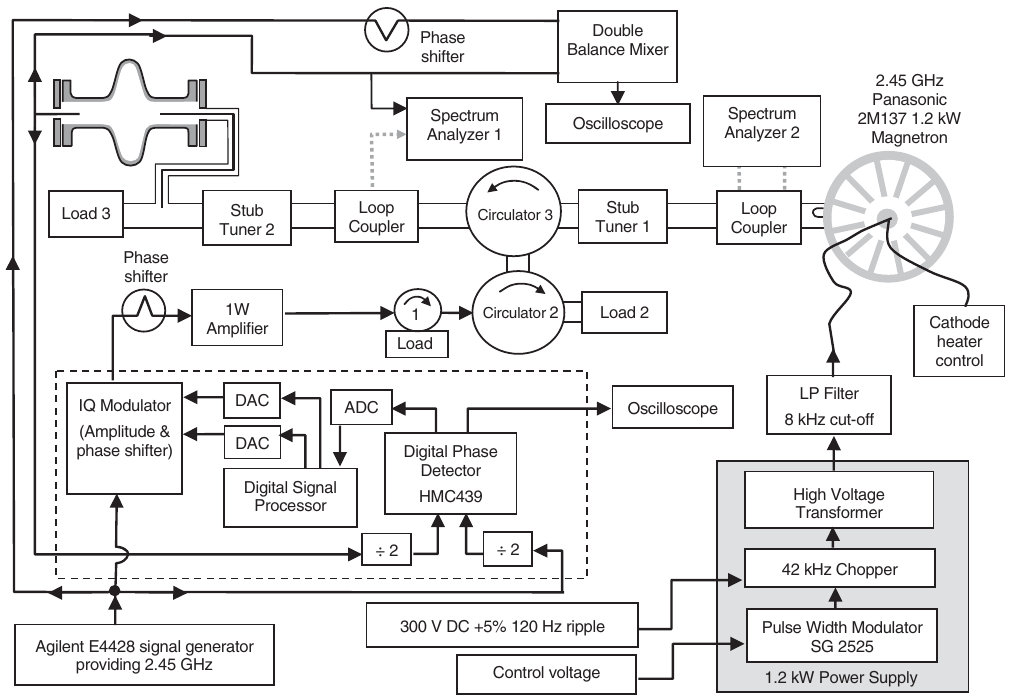
FIG. 3. Low and high level rf control layout of the magnetron phase lock to a superconducting rf